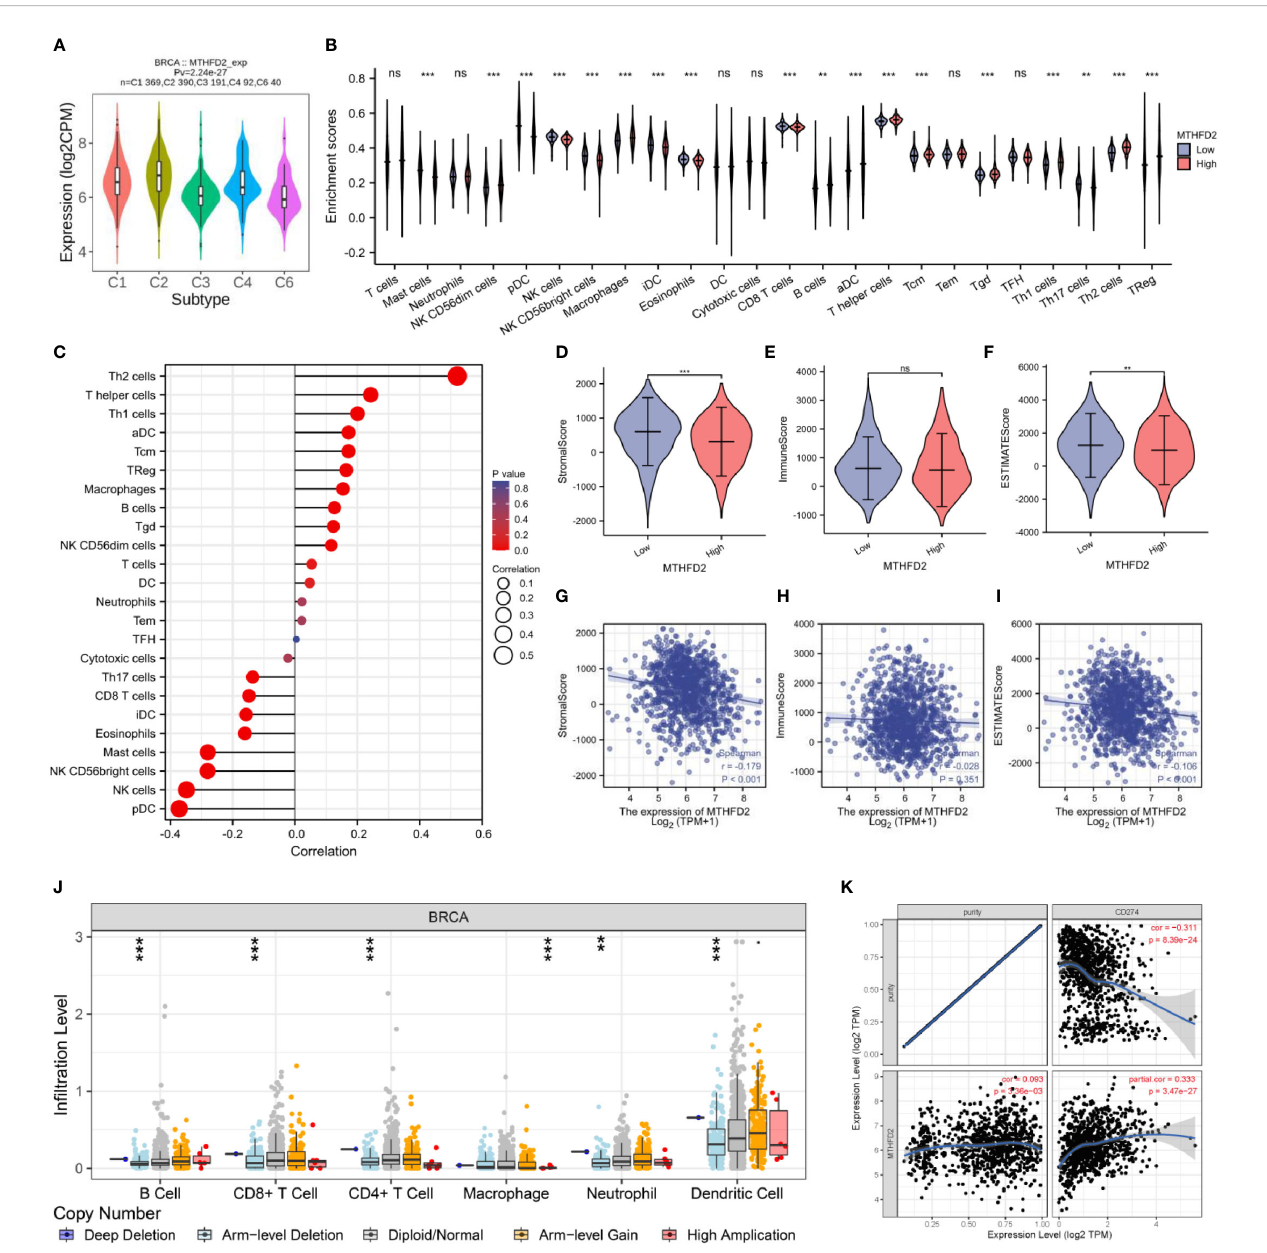
FIGURE 7 The correlation between MTHFD2 expression and in fi ltrating immune cells in breast cancer. (A) Correlation analysis between MTHFD2 expression and immune subtypes. C1: wound healing, C2: interferon-gamma dominant, C3: in fl ammatory, C4: lymphocyte depleted, C5: immunologically quiet, C6: TGF- b dominant. (B) Analysis of immune cell in fi ltration in breast cancer patients with high and low MTHFD2 expression. (C) Correlation analysis between MTHFD2 expression and immune cell in fi ltration. (D – F) Stromal, immune, and ESTIMATE scores in high and low MTHFD2 expression groups. (G – I) Correlation analysis between MTHFD2 expression and stromal, immune, and ESTIMATE scores. (J) Correlation analysis between MTHFD2 mutation and immune in fi ltration. (K) Correlation analysis of MTHFD2 expression with immune checkpoints PD-L1 in breast cancer. ns: p ≥ 0.05, * p <0.05, ** p <0.01, *** p <0.001, **** p